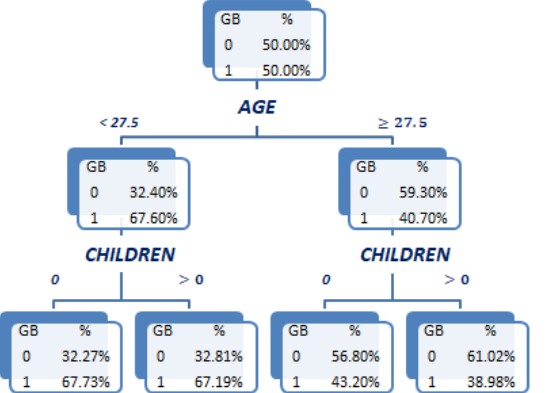
Figure 5. CART tree fitted with variables AGE and CHILDREN in the CS _ ACCEPTS (depth =